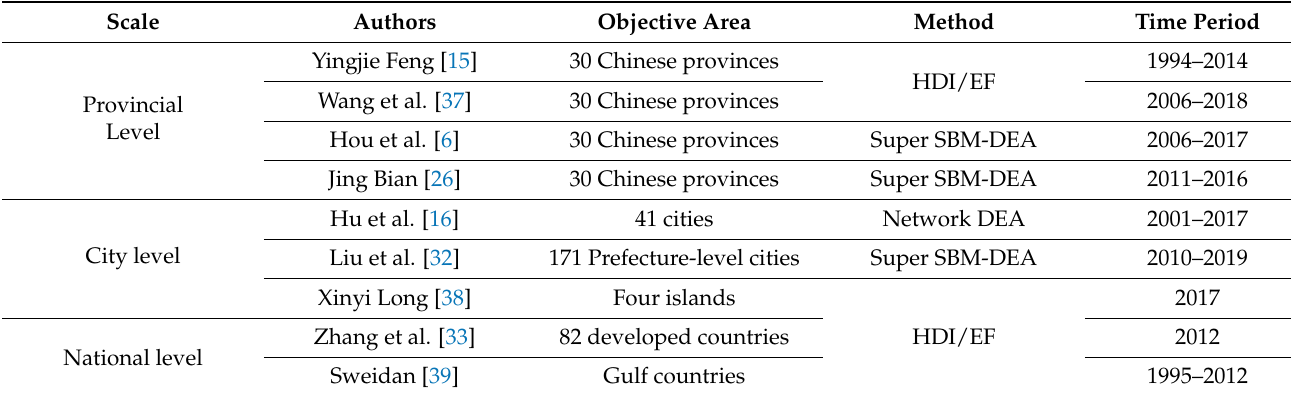
Table 1. Existing EWP